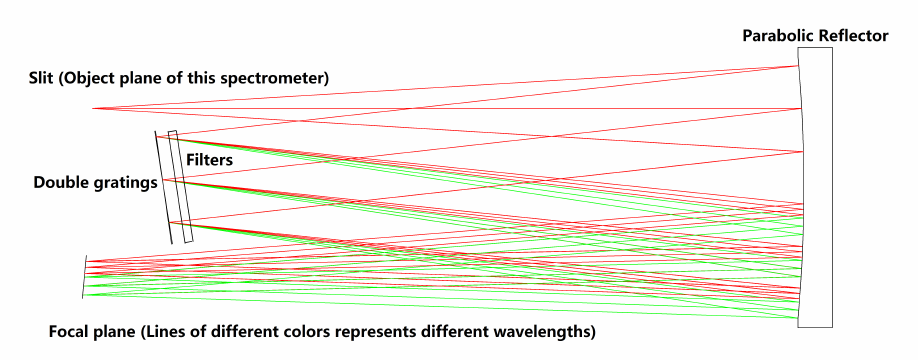
Figure 9. The dual-gratings imaging